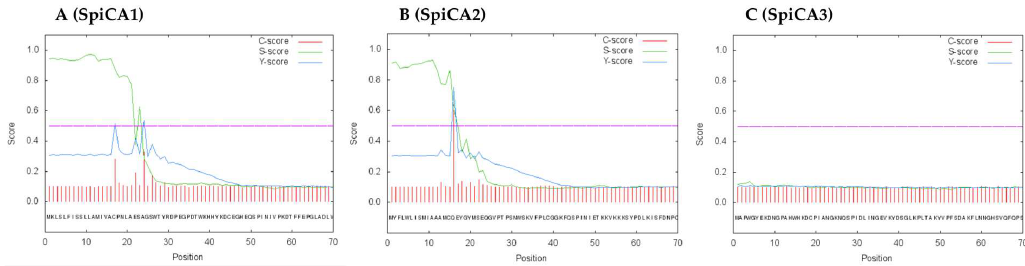
Figure 3. SignalP graphical output showing the three different scores C, S and Y, for the first 70 positions in the SpiCA1 (Panel A ), SpiCA2 (Panel B ), and SpiCA3 (Panel C ) amino acid sequences. The program recognized the presence of a signal peptide at the N-terminal of the SpiCA1 and SpiCA2 amino acid sequences, but did not detect any signal peptide in SpiCA3. Legend: X -axis, amino acid position; C-score, raw cleavage site score; S-score, signal peptide score; Y-score, combined cleavage site score.